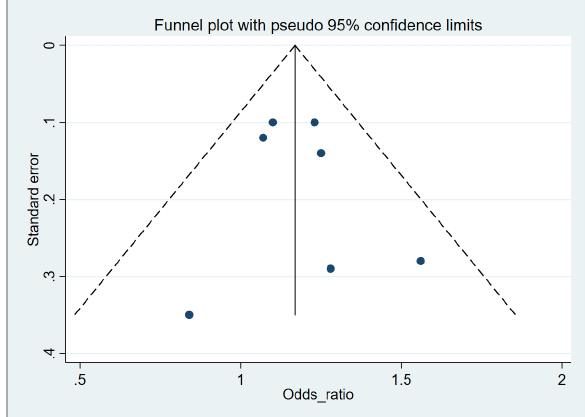
Figure 3. Publication bias for the relationship between dietary acid load and the incidence of